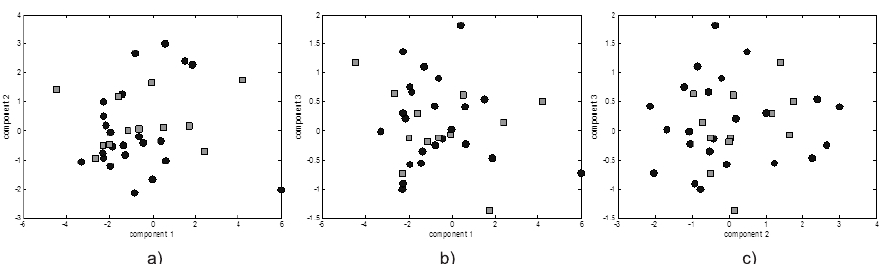
Figure 11. Observations from treatment group divided into groups of irradia- tion of central nervous system indication on principal component